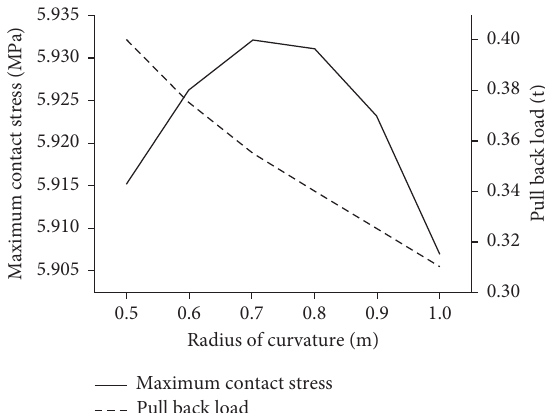
Figure 10: Relationship between curvature radius, pullback force, and contact